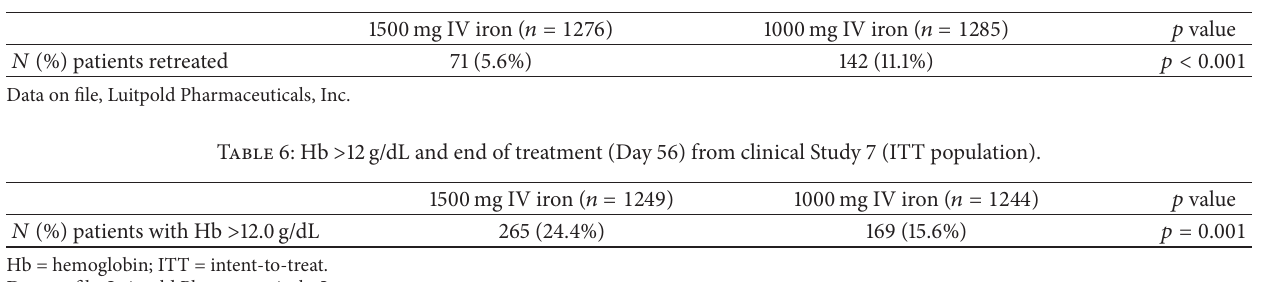
Table 5: Retreatment between Days 56–90 in clinical Study 7 (Safety Population).